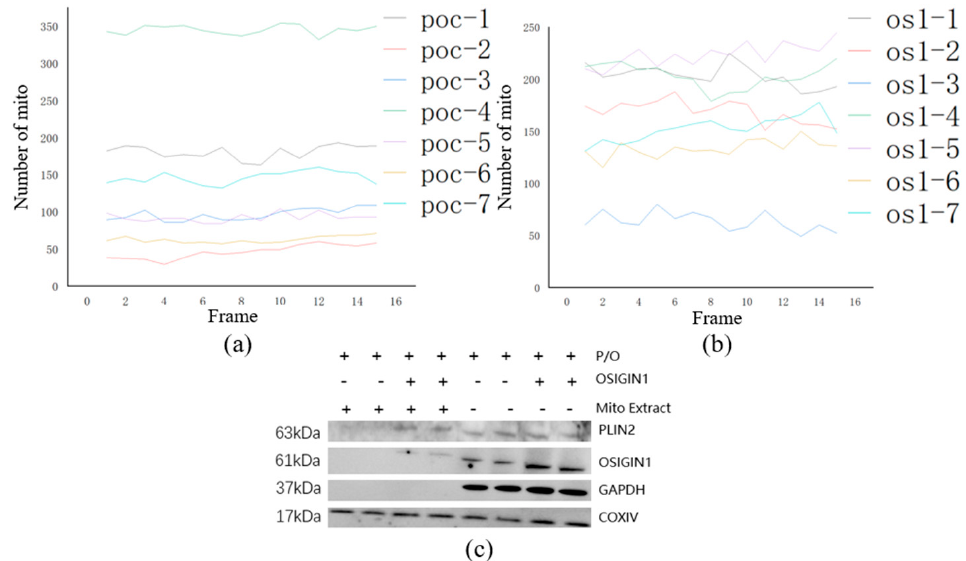
Figure 12. Normal mouse hepatocytes and OSGIN1 gene overexpressed cells were collected every 30 s, and mitochondrial recognition and counting were performed using MATLAB development tools. ( a ) the change trend map of the number of mitochondria in normal cells. ( b ) the change map of the number of mitochondria in OSGIN1 gene overexpression cells. ( c ) the result of immunoblotting. The samples from left to right are normal cells to extract mitochondria, OSGIN1 gene overexpression cells to extract mitochondria, normal cells, and OSGIN1 gene overexpression cells. All cells were treated with P/O under the same conditions.